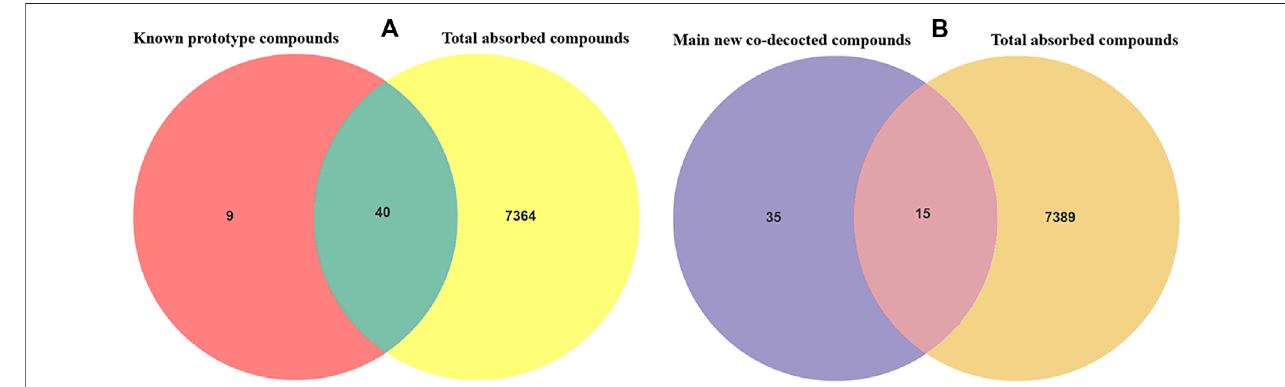
FIGURE 4 | Venn diagram of the known prototype drug absorbed into the blood (A) ; the Venn diagram of the main new generated compounds absorbed into the blood after co-decoction of Shuangxia decoction (B) . By the intersection analysis of the m/z values and retention time of the known prototype compounds and the m/z valuesandretentiontimeofallthecompoundsabsorbedintothebloodfromShuangxiadecoction,40knowncompoundswerefoundtobeabsorbedintotheblood.As indicated above, 15 new compounds were found to be absorbed into the blood after